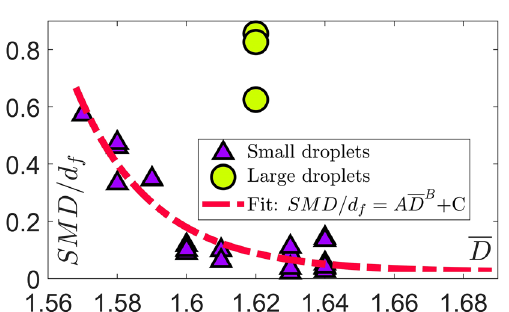
Figure 8. Decoupling in small (triangles) and large (circles) droplets represented by Suater mean diameter (SMD) as a global size. The “small” droplets belong to a class following a power-law correlation, while the “large” droplets behave independently. The power-law correlation SMD / d f = AD B + C between the averaged fractal dimensions D and SMD ( d f : liquid discharge diameter) with coefficients A = 3.327 × 10 13 , B = − 70.2, C = 0.0229 is represented by the red